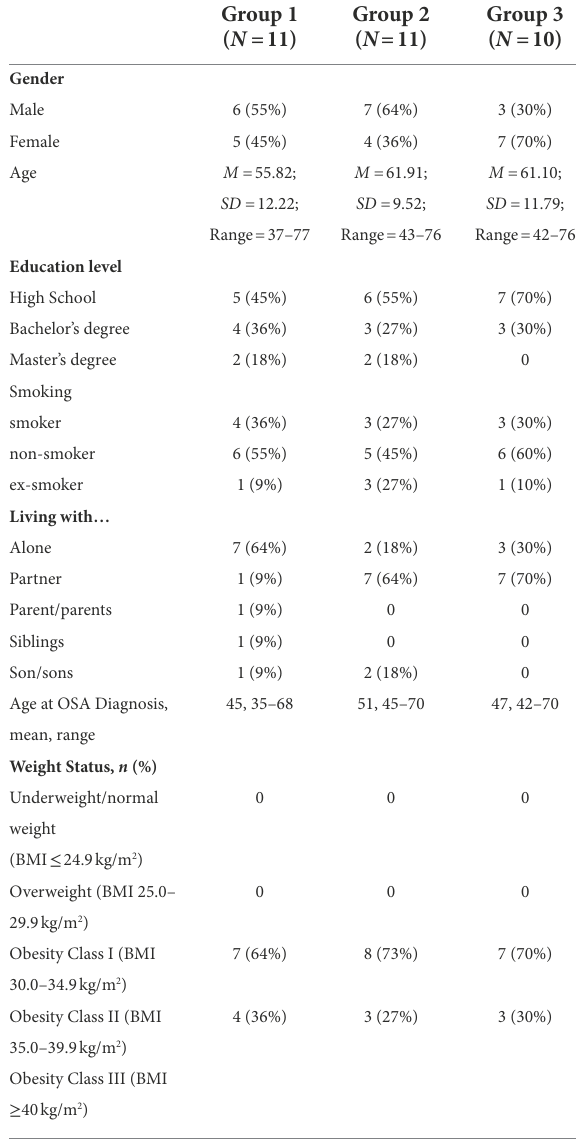
TABLE 1 Demographic and clinical information about the sample ( N =